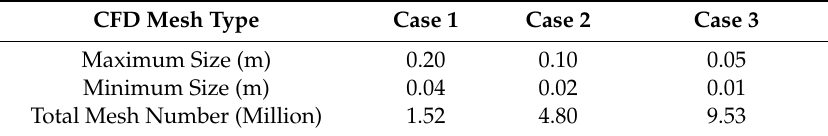
Table 6. Mesh size of blade surface.